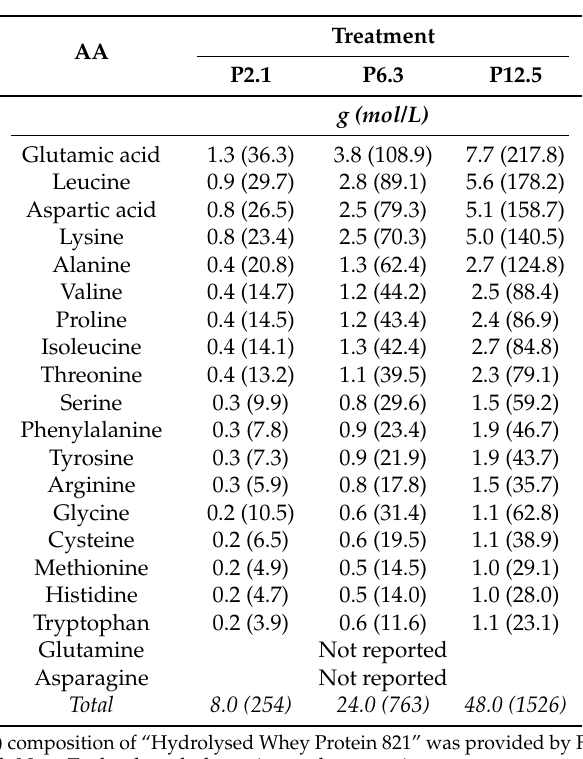
Table 1. The amino acid (AA) composition of the whey protein infusion solutions a,b,c